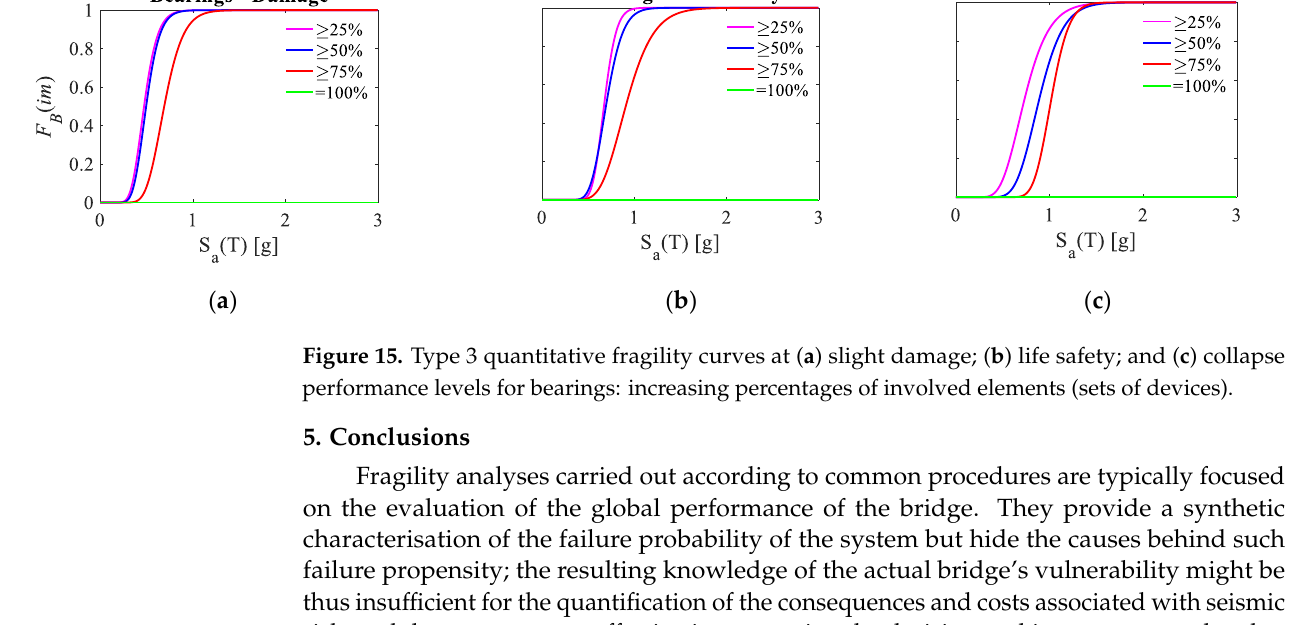
Figure 15. Type 3 quantitative fragility curves at ( a ) slight damage; ( b ) life safety; and ( c ) collapse performance levels for bearings: increasing percentages of involved elements (sets of devices).